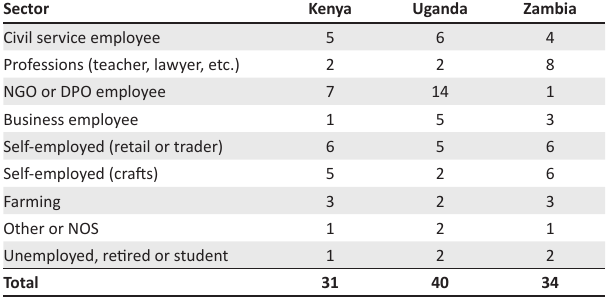
TABLE 3: Livelihood outcomes for participants. Sector Kenya Uganda